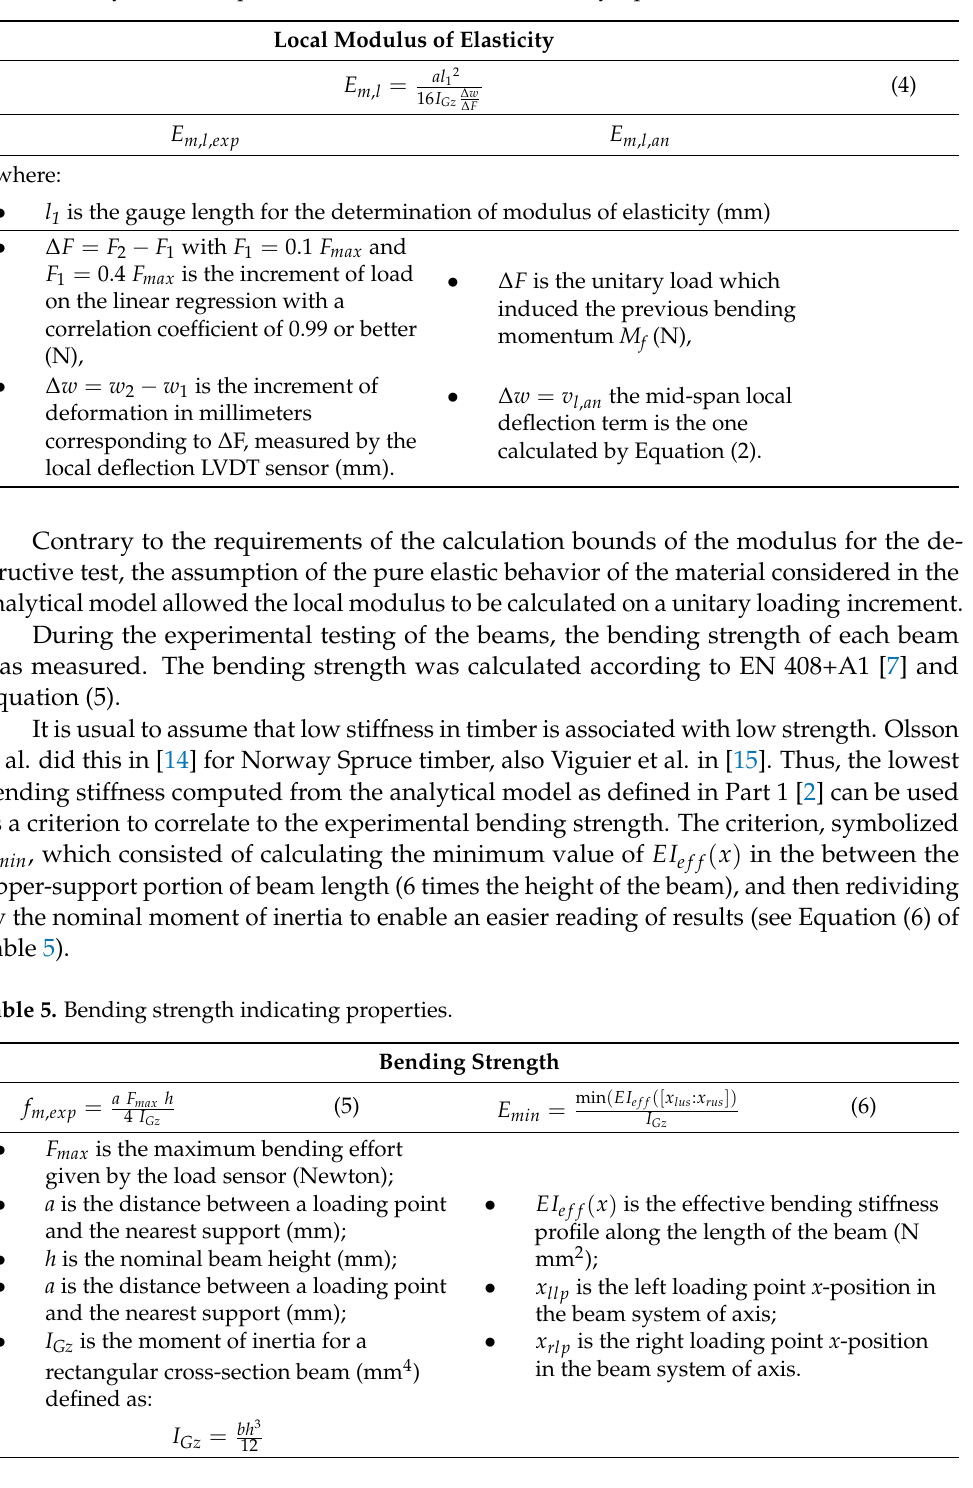
Table 4. Analytical and experimental local modulus of elasticity equation.